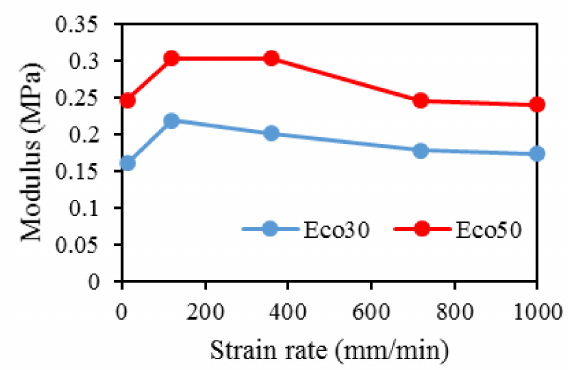
Figure 15. Modulus for Eco30 and Eco50 at di ff erent strain